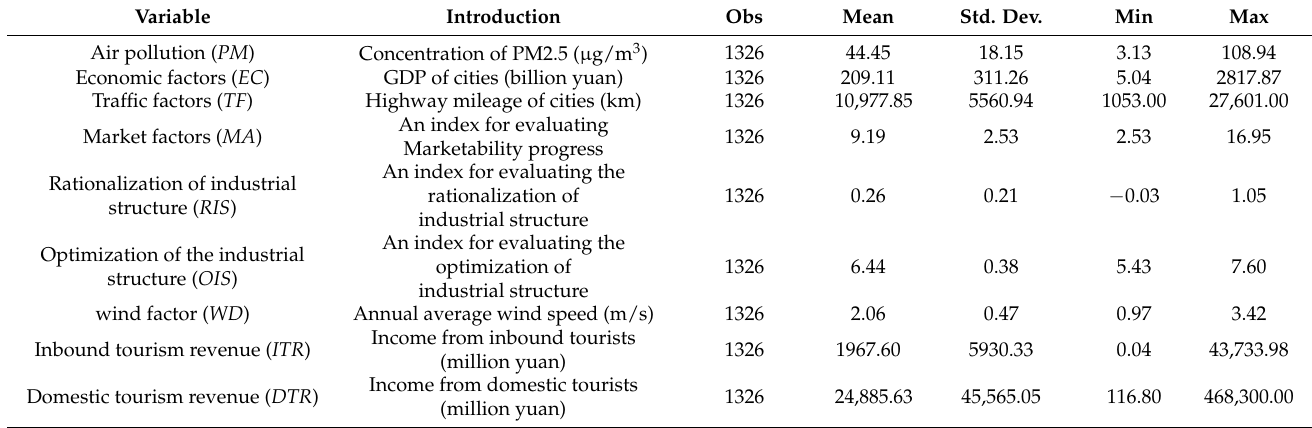
Table 1. Variable names and descriptive